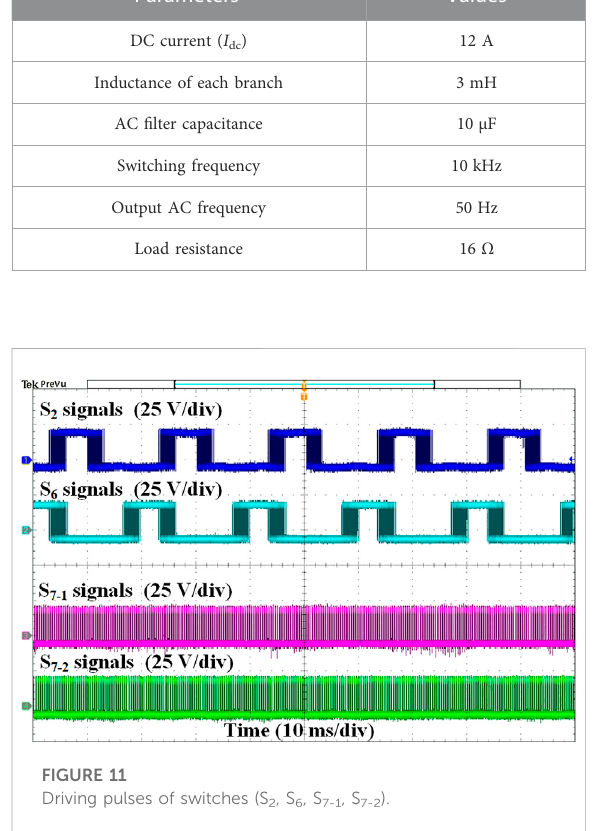
TABLE 4 Parameters of the experimental prototype. Parameters